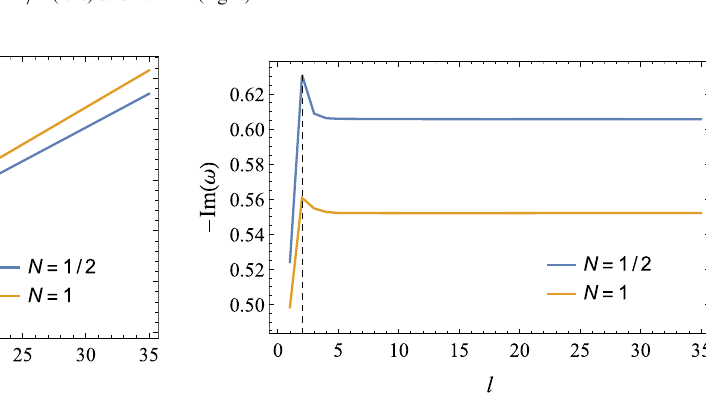
Fig. 13 V ( r ) with respect to r for the cases of N = 1 / 2 (left) and N = 1 (right)